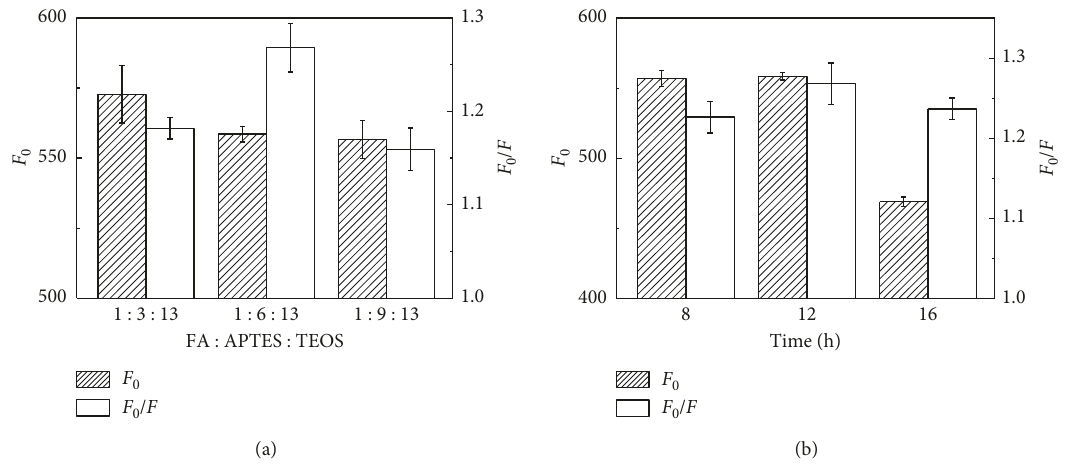
Figure 1: Effect of the ratio of FA: APTES:TEOS (a) and polymerization time (b) on the fluorescence response and quenching efficiency of CdTe-QDs@MIPs (concentration of FA at 10 μ g/l).